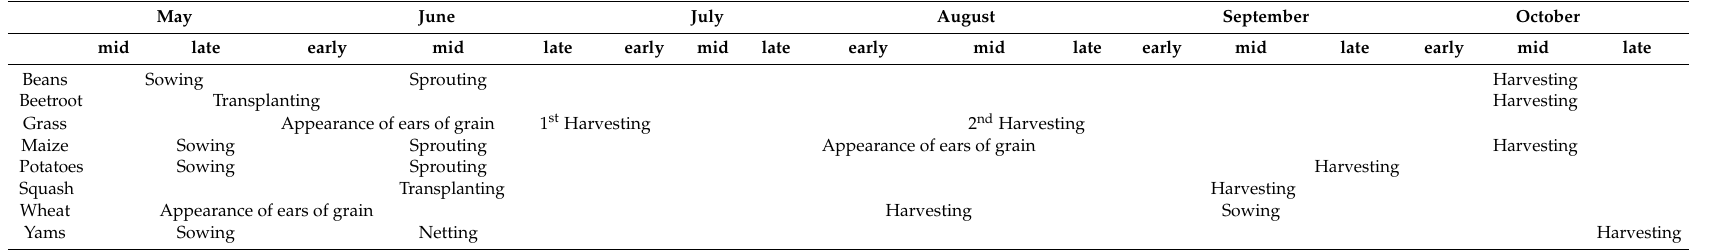
Table 1. The cultivation calendar for